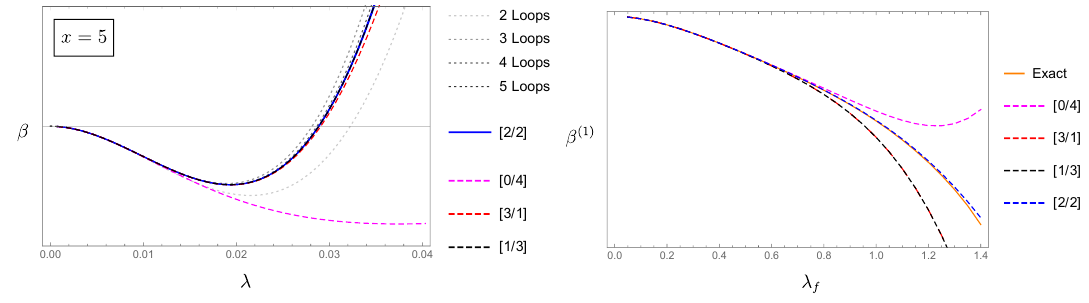
Figure 3 . Left: (cid:12) -function as a function of the coupling (cid:21) in the Veneziano limit. Dotted grey lines denote perturbative results, dashed lines denote the Borel resummations using Pad(cid:19)e approximants as indicated in the legend. The barely visible error band of the [2 = 2] approximant appears here as a continuous blue line and the central values of the [2 = 2] and [1 = 3] approximants are overlapped. The error band corresponds to c np = 10. Right: coe(cid:14)cient of order 1 =n f of the (cid:12) -function as a function of the coupling (cid:21) f . The continuous orange line denotes the exact result obtained using large- n f methods, the dashed lines denote the Borel resummation using Pad(cid:19)e approximants as indicated in the